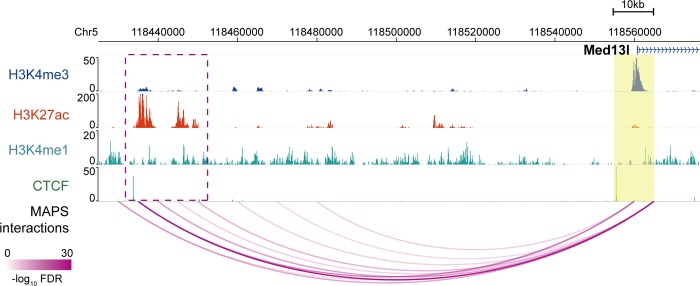
MAPS-identified interactions from mESC H3K4me3 PLAC-seq data anchored at Med13l promoter.Anchor region around target promoter is highlighted by yellow box. The MAPS-identified interactions overlapping this anchor region are marked by magenta arcs. The deleted enhancer region in Moorthy et al study [24] is marked by magenta box.